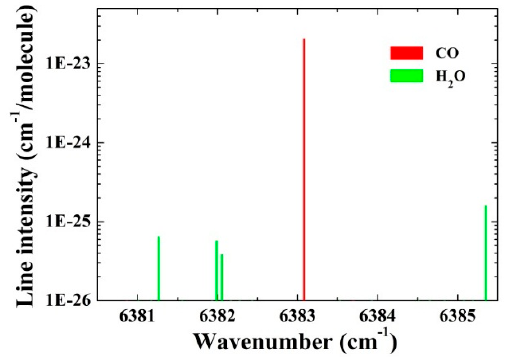
Figure 2. Absorption lines of CO and H 2 O between 6380.5 cm − 1 and 6385.5 cm − 1 .